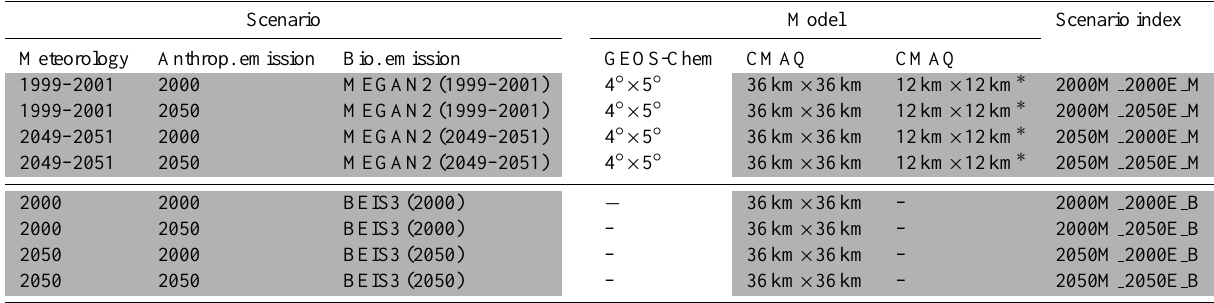
Table 4. Summary of CMAQ simulations conducted in this study.